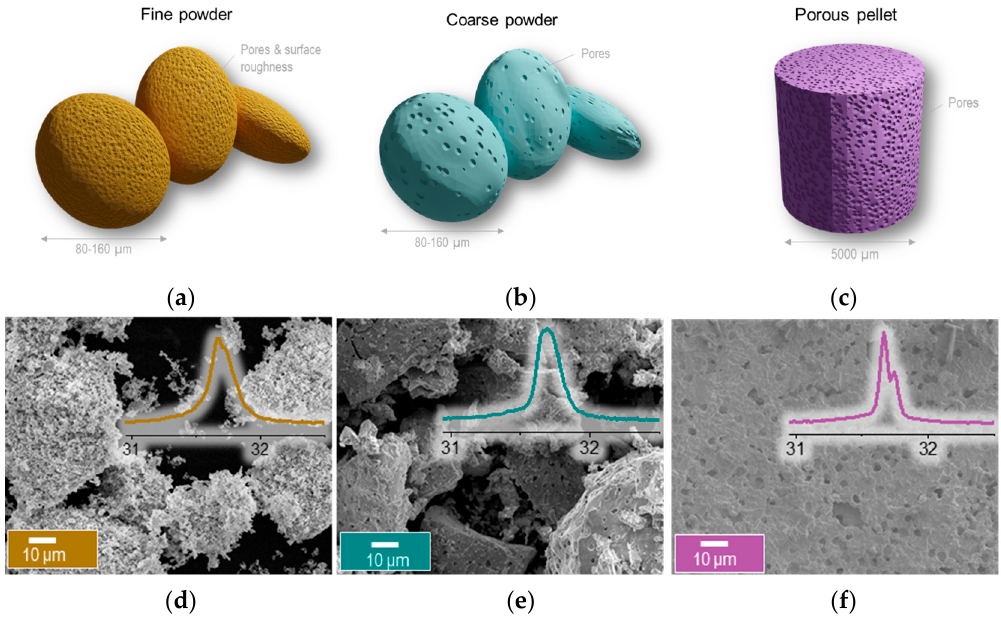
Figure 3. Creating perovskites with different microstructures. ( a – c ) Illustration of the three different microstructures. Microstructure (SEM) of the La 0.8 Ce 0.1 Ni 0.4 Ti 0.6 O 3 perovskite after micromanipulation to create different microstructures as ( d ) fine powder (fP) ( e ) coarse powder (cP) ( f ) pellet (pP) with inserts of the XRD pattern of the main perovskite peak.